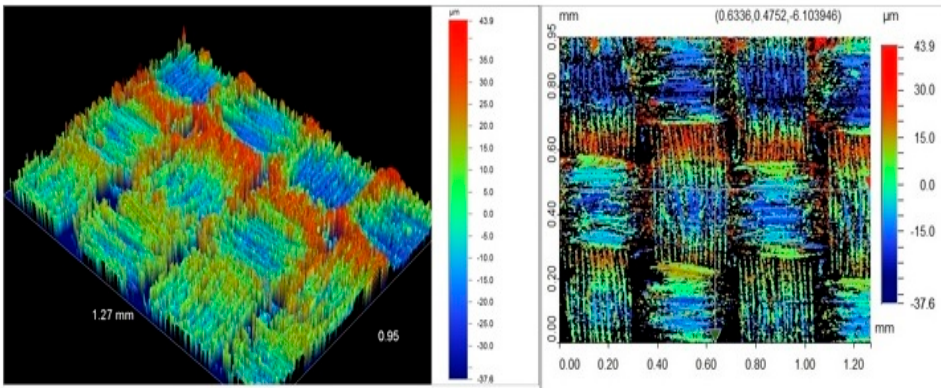
Figure 11. 3-D and 2-D images of topographic surface of CFRP strip with IHSSC-CA.